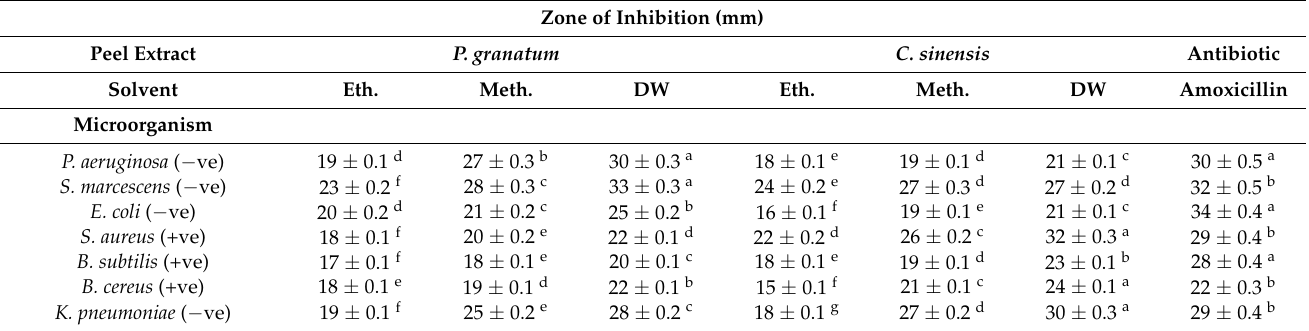
Table 10. Antimicrobial activity of peel extracts (ethanolic, methanolic, and distilled water) against different microorganisms. Zone of Inhibition (mm)